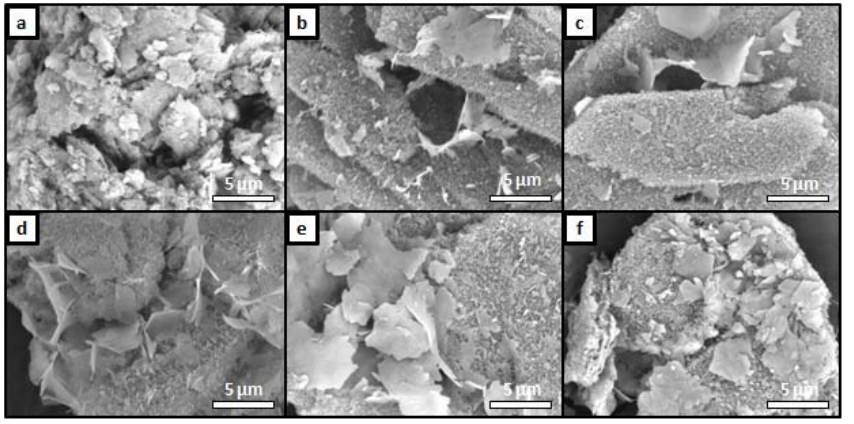
Figure 3. SEM micrographs of the OCP surface: ( a ) OCP; ( b ) OCP-Sr_1; ( c ) OCP-Sr_5; ( d ) OCP-Sr_10; ( e ) OCP-Sr_20; ( f ) OCP-Sr_50. Table 2. Chemical components of samples OCP and OCP-Sr,